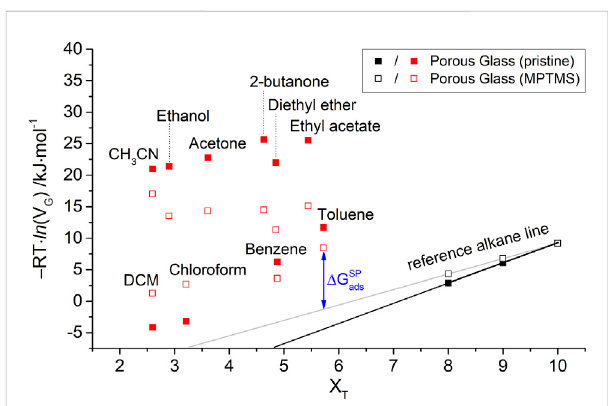
FIGURE 3 Free energy of adsorption Δ G ads for n -alkanes and polar